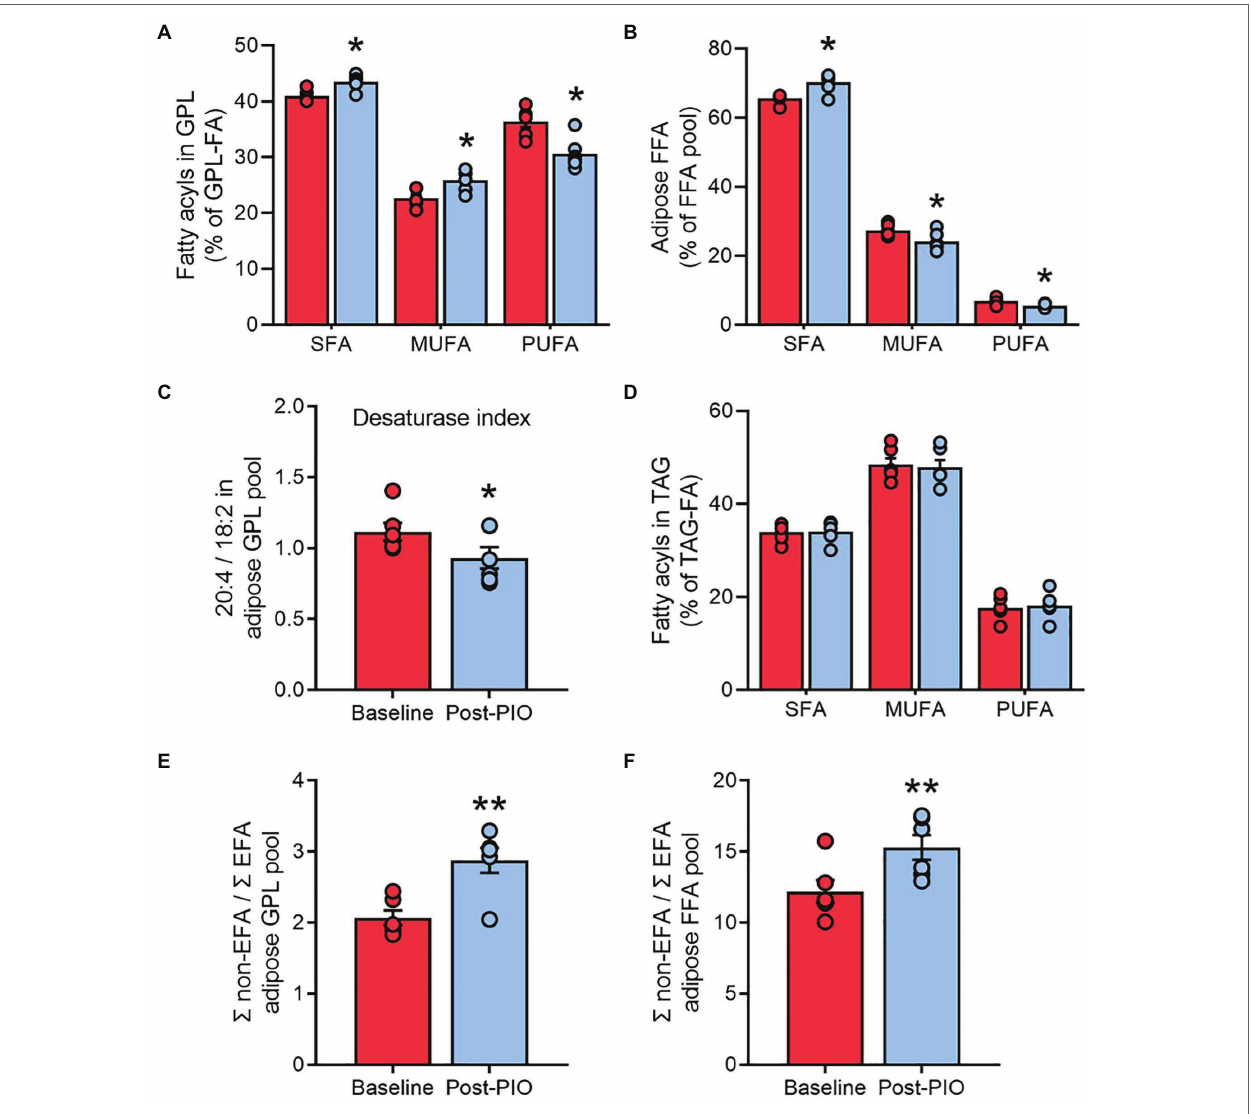
FIGURE 3 | Pioglitazone increases the saturation of membrane lipids in adipose tissue. Contribution of saturated fatty acids, monounsaturated fatty acids, and polyunsaturated fatty acids to total fatty acyl groups in the glycerophospholipid (A) , free fatty acid (B) , and triglyceride (D) pools; ratio of 20:4 to 18:2 fatty acyl groups in glycerophospholipids as an index of fatty acid desaturase activity (C) ; ratio of non-essential fatty acids (non-EFA) to essential fatty acids as an index of de novo lipogenesis in the glycerophospholipid (E) and free fatty acid (F) pools from adipose tissue at Baseline (red) and following 6 months of 45 mg/day pioglitazone treatment (blue). * p < 0.05, ** p < 0.01 vs. Baseline. Data are mean ± standard error (filled bars) and individual values (filled circles) for n = 6